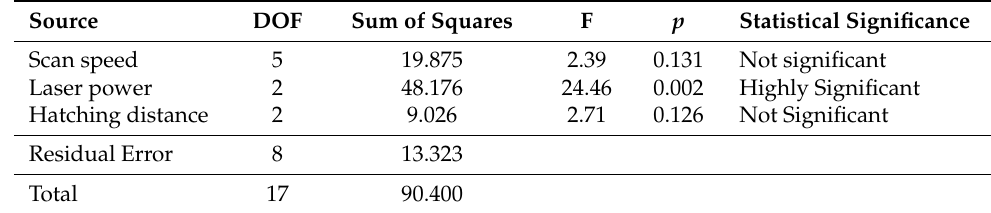
Table 5. Analysis of Variance for S/N ratios. R 2 = 85.26%.